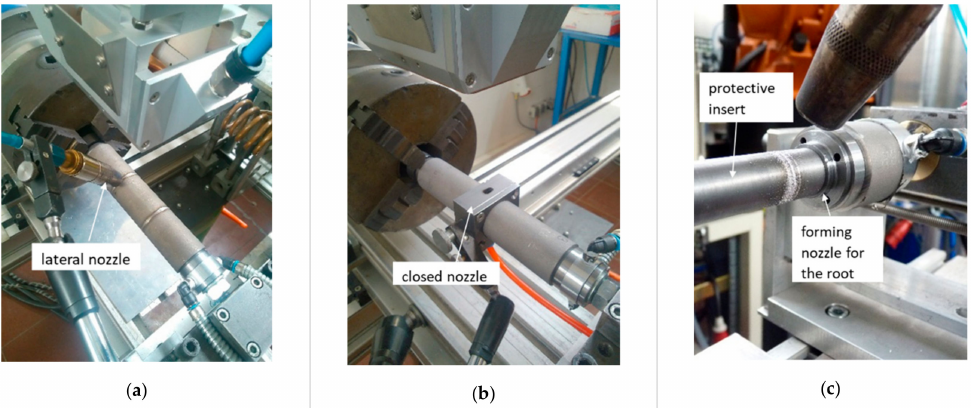
Figure 1. Experimental setup: ( a ) the variant with the lateral nozzle, ( b ) the variant with the closed nozzle, ( c ) the view of the forming nozzle for the root forming gas and protective